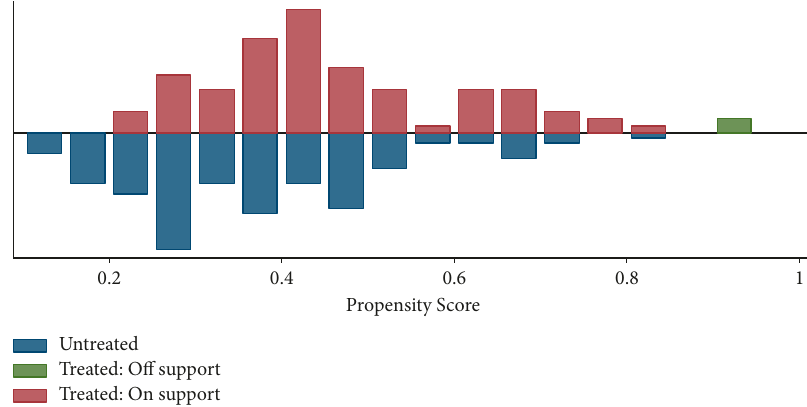
Figure 1: Distribution of propensity score (80 of 83 treated samples are in the common support region). Table 3: Estimation of average treatment effect (ATT): estimating the impact of row planting on wheat productivity. NN-matching Radius(0.1)